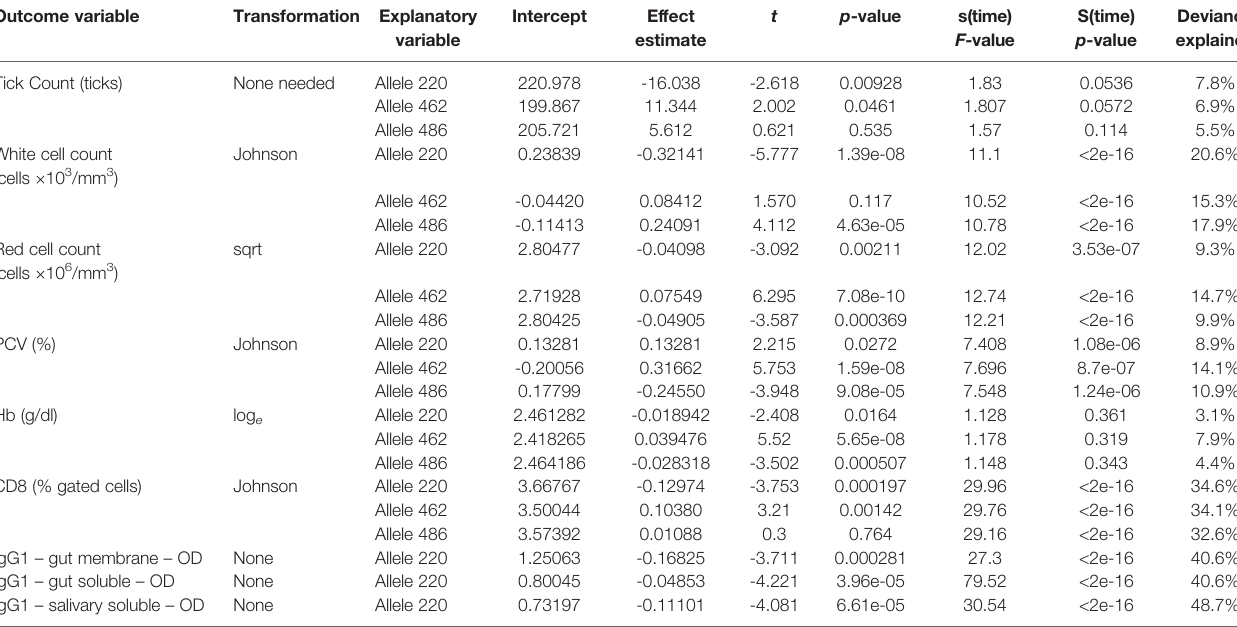
TABLE 5 | Summary of GAM outputs for each of the models for tick count and each of the variables for which the main effect of allele frequency was considered to be statistically signi fi cant ( p < 0.00083). Outcome